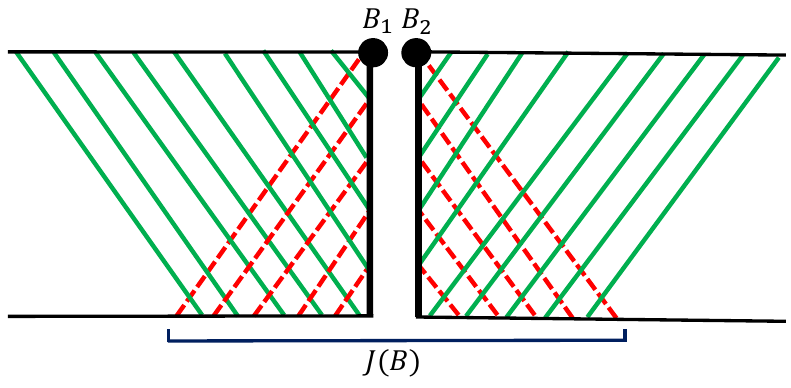
Figure 14 . Operator growth in the toy model of a black hole with a free